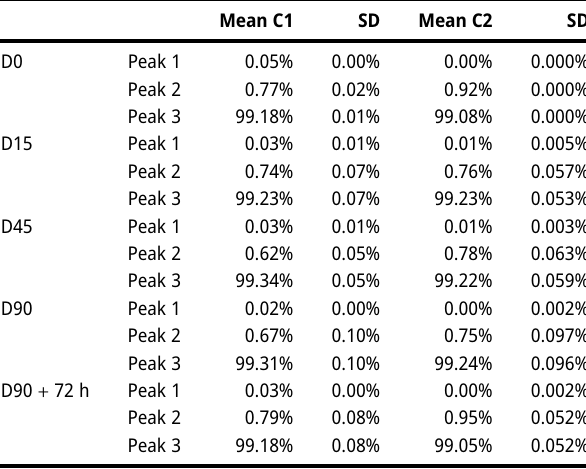
Table  : Peak percentages demonstrated by SEC for bags following dilution to  .  mg/mL (C  ) and  .  mg/mL (C  ).